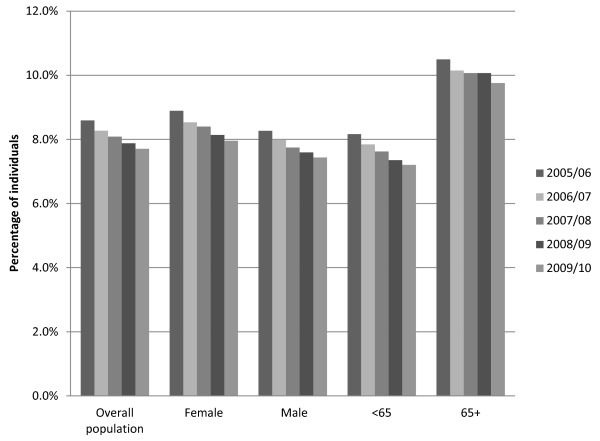
Percentage of adult (age 19+) Nova Scotia residents who filled at least one prescription for paracetamol/opioid, by sex and age, and overall, per one-year period: July 1, 2005 to June 30, 2010. Denominator is adult population of Nova Scotia for each year, based on data from Statistics Canada.